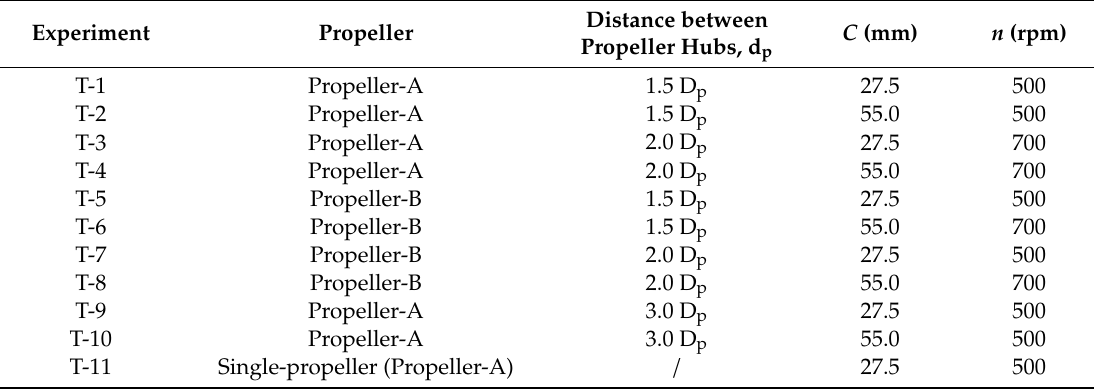
Figure 5. Dimensions of the scour profile induced by twin-propeller. Table 3. Summary of experiments.